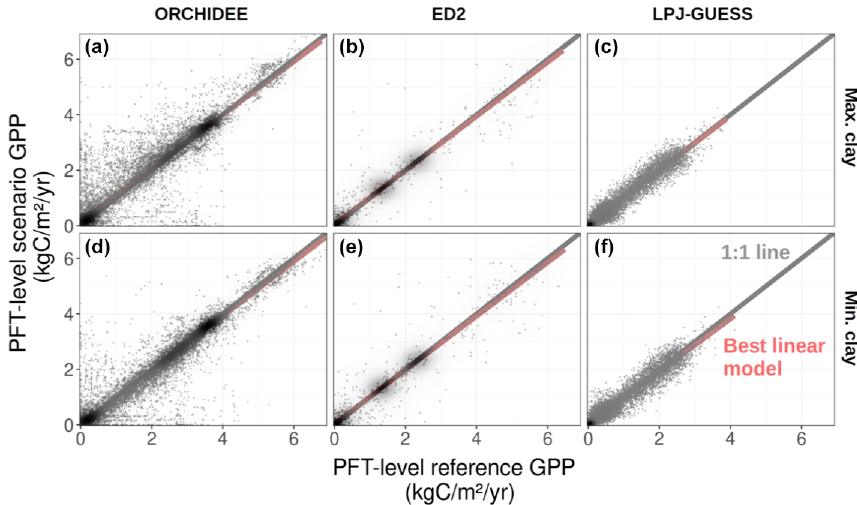
Figure 4. Scenario (Max. clay: a–c and Min. clay: d–f ) versus reference (Mean clay scenario) GPP for each TBM used in this study. Each dot is the PFT-level GPP over a specific grid cell (1 ◦ resolution) at the end of the historical period (2016).